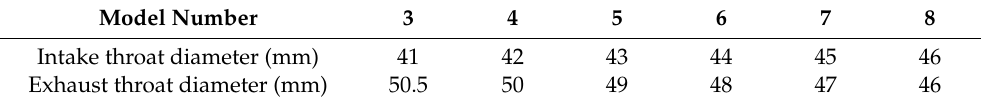
Table 3. Throat size of intake and exhaust core box.